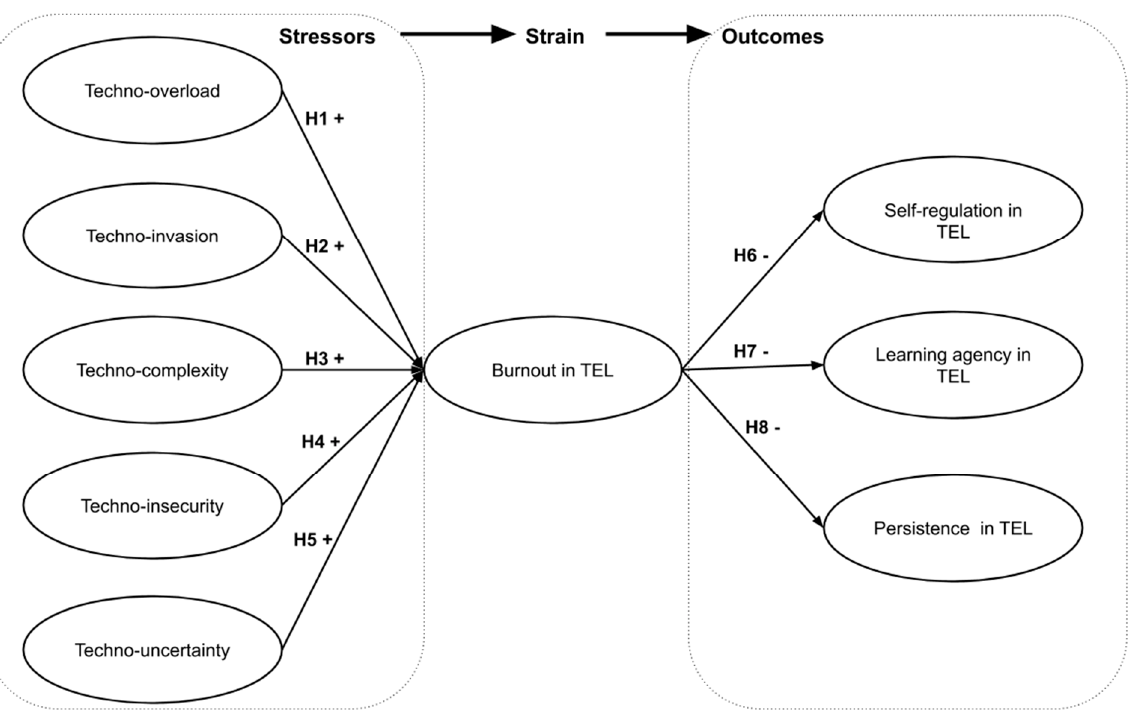
Figure 1. Hypothesized stressor-strain-outcome (SSO) model of technostress. Note. “+” suggests positive relationships; “ − ” suggests negative